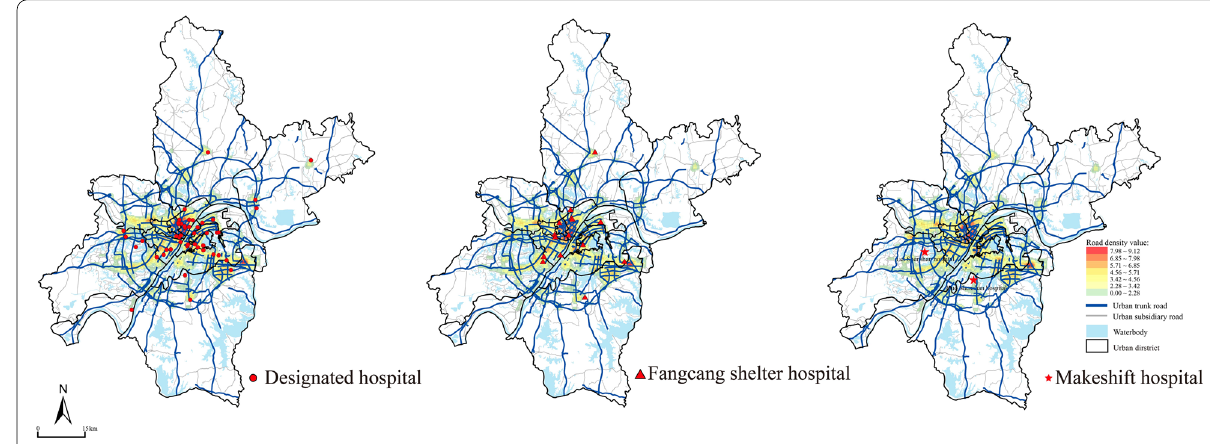
Fig. 6 The relationship between three emergency medical facilities and road environment